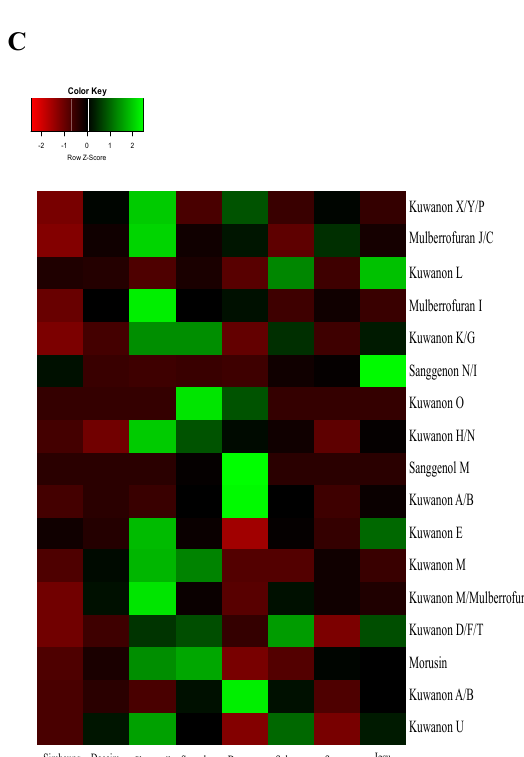
4 of 19 Figure 1. Representative ultra-performance liquid chromatography–quadrupole-time-of-flight mass